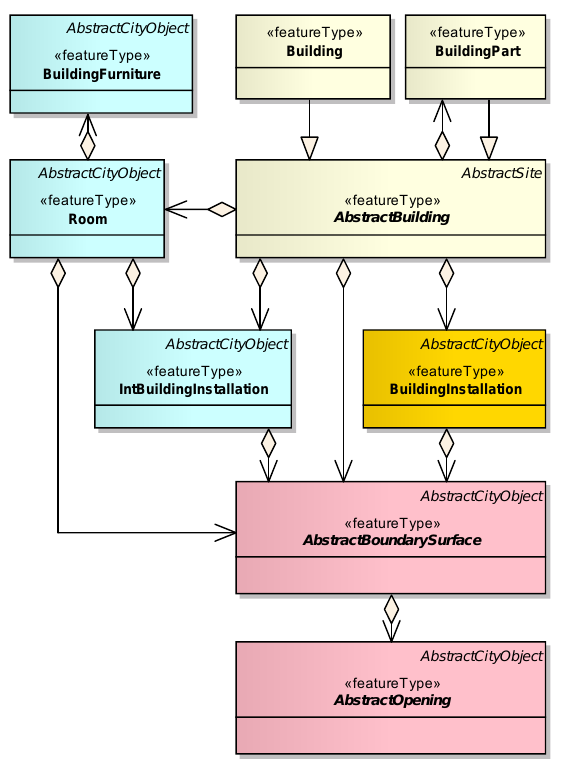
Figure 7: General structure of the CityGML Building module